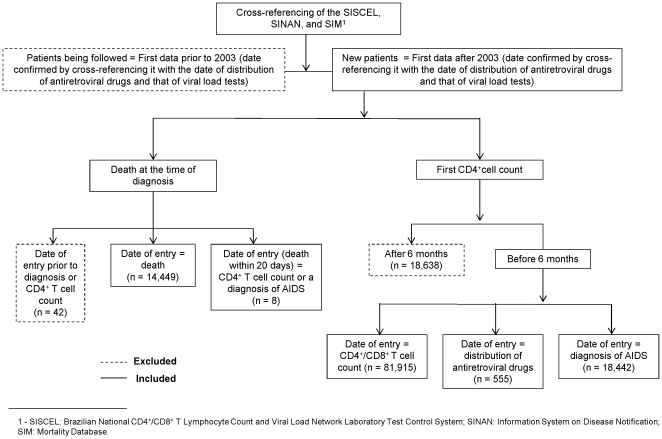
Flowchart for the inclusion of adult HIV+ in the study.